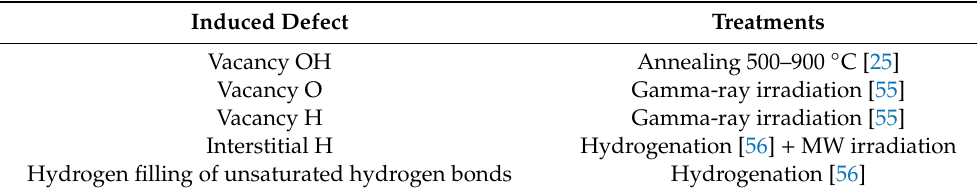
Table 5. Treatment types and induced